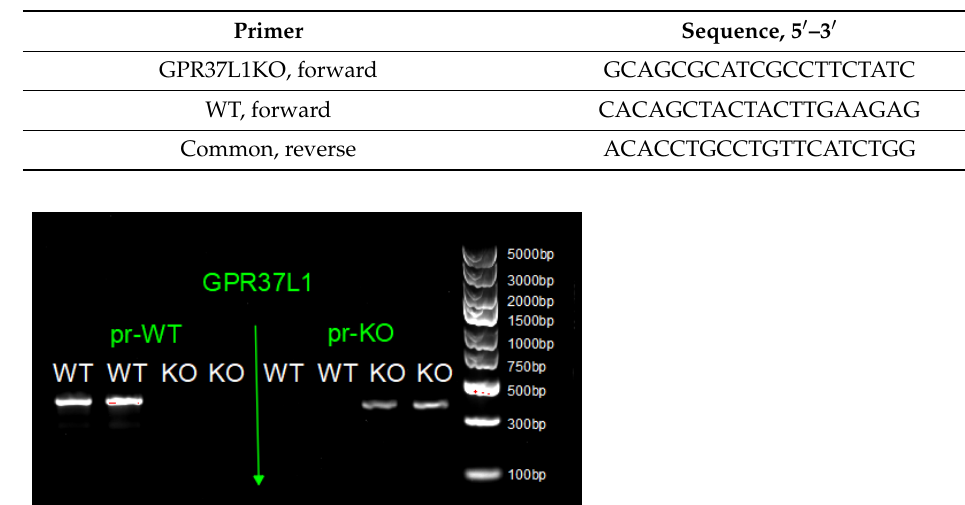
Table 1. Primers used for GPR37L1 genotyping.